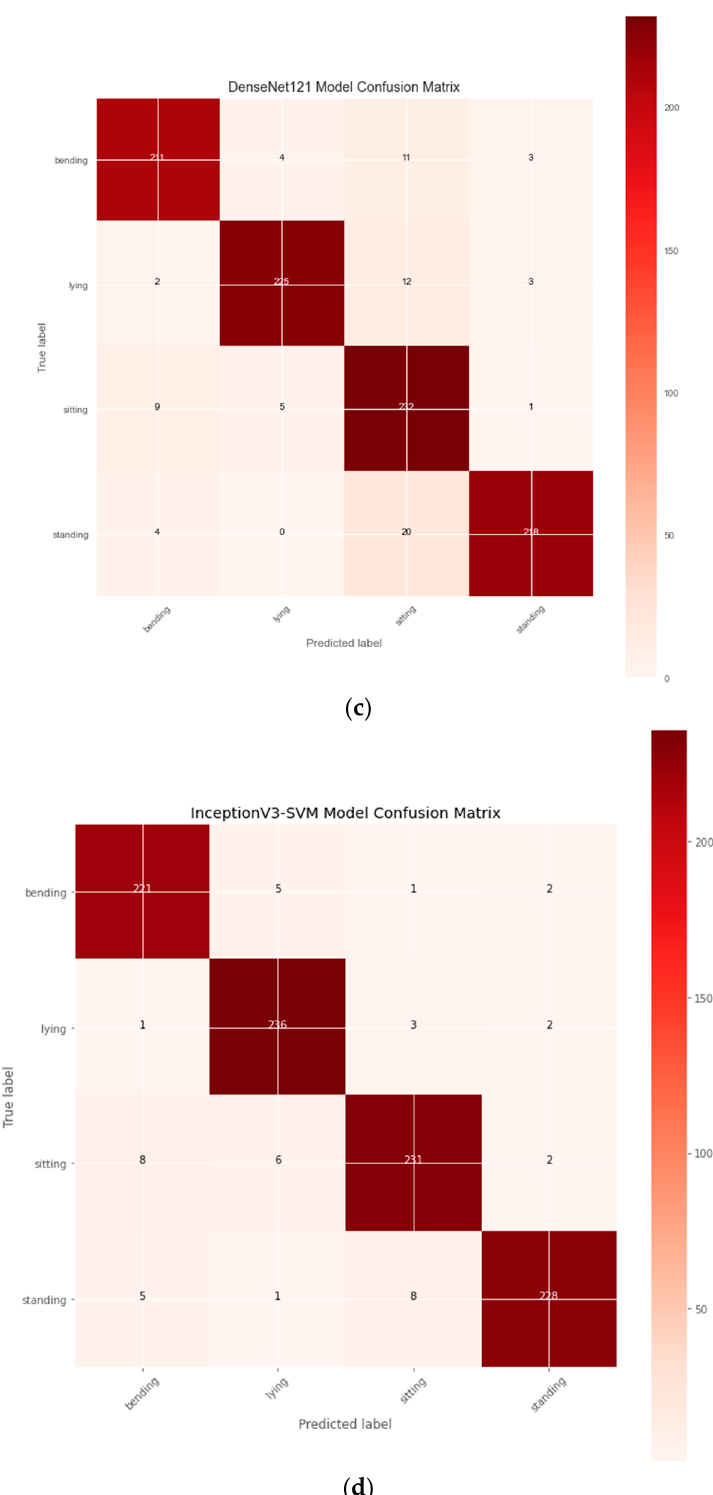
Figure 3. Confusion matrix of DCNN models: ( a ) InceptionV3; ( b ) ResNet50; ( c ) DenseNet121; and ( d ) Proposed InceptionV3-SVM .